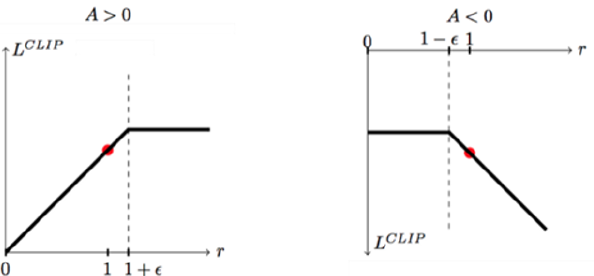
Figure 7. The clip function for the PPO algorithm. When the difference between the old policy and the new policy is less than 1 or slightly greater than 1, the clipping function does not work; only when the difference between the old policy and the new policy is too large will the clipping function limit the difference between the old policy and the new policy to 1 + ε .